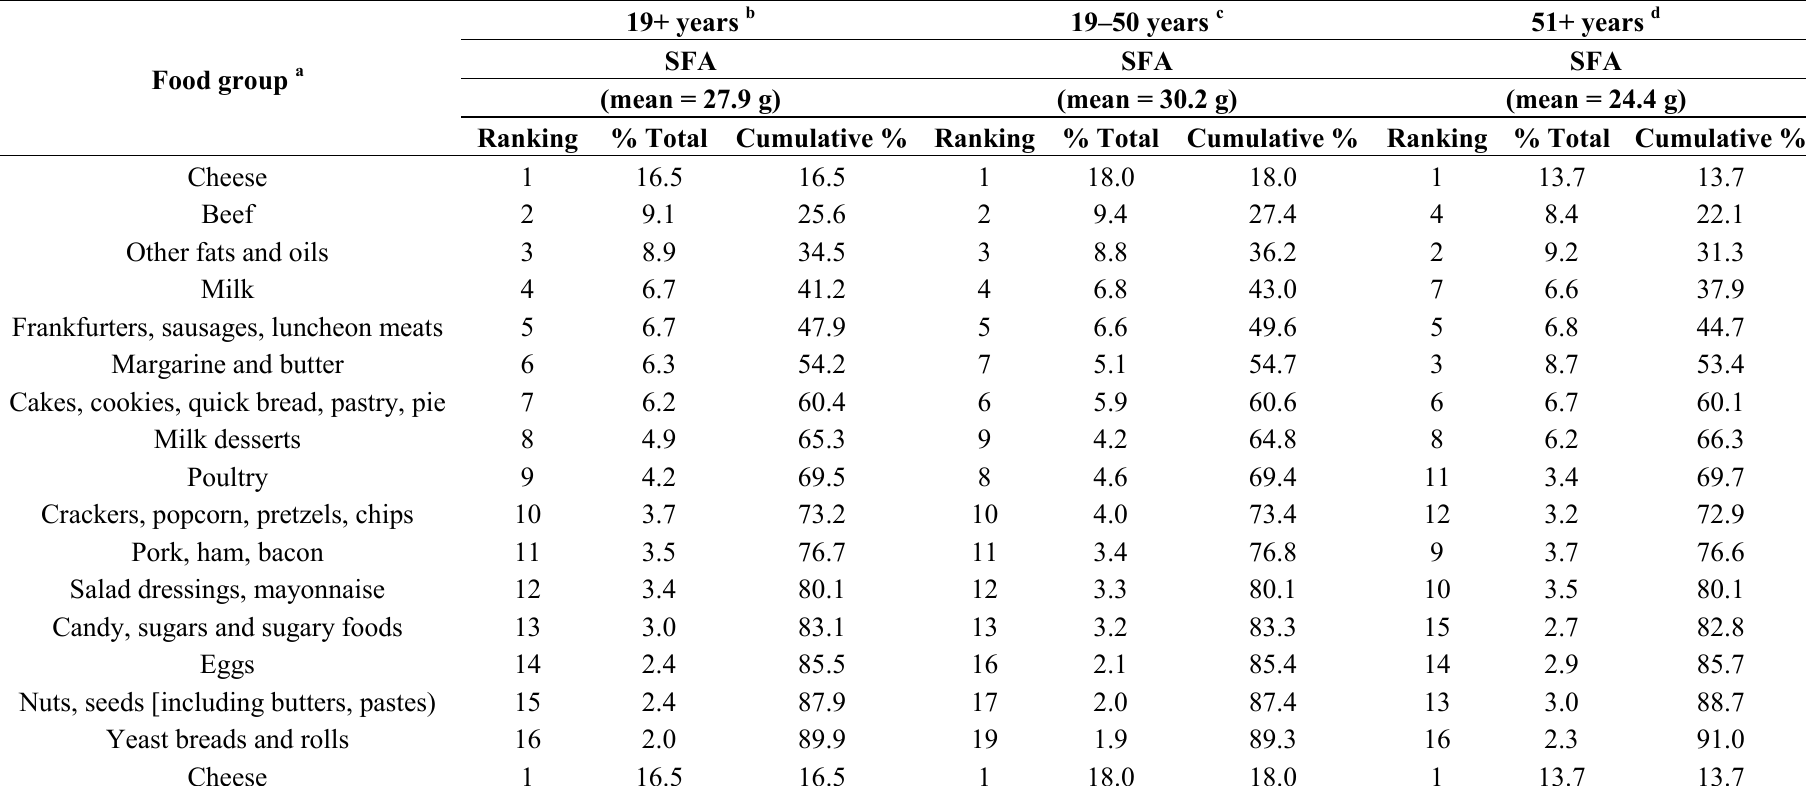
Table 5. Food sources of saturated fatty acids (SFA) among US adults (from NHANES 2003–2006).